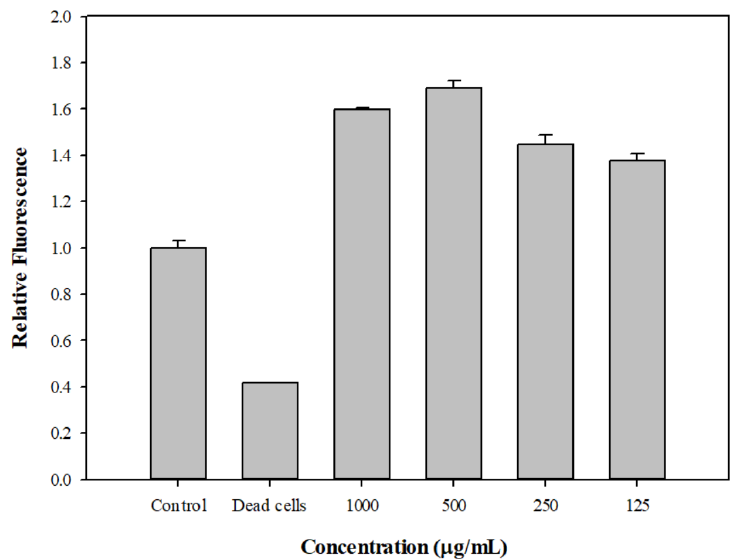
Figure 5. Effect of diphenyl methane on the membrane permeabilization of E. coli Kam3-AcrB. The membrane permeability was determined by using fluorescence dyes SYTO9 and propidium iodide, and the fluorescence was recorded at an Ex of 470 nm and an Em of 540 nm. Data are expressed as mean ± SD ( n = 3).